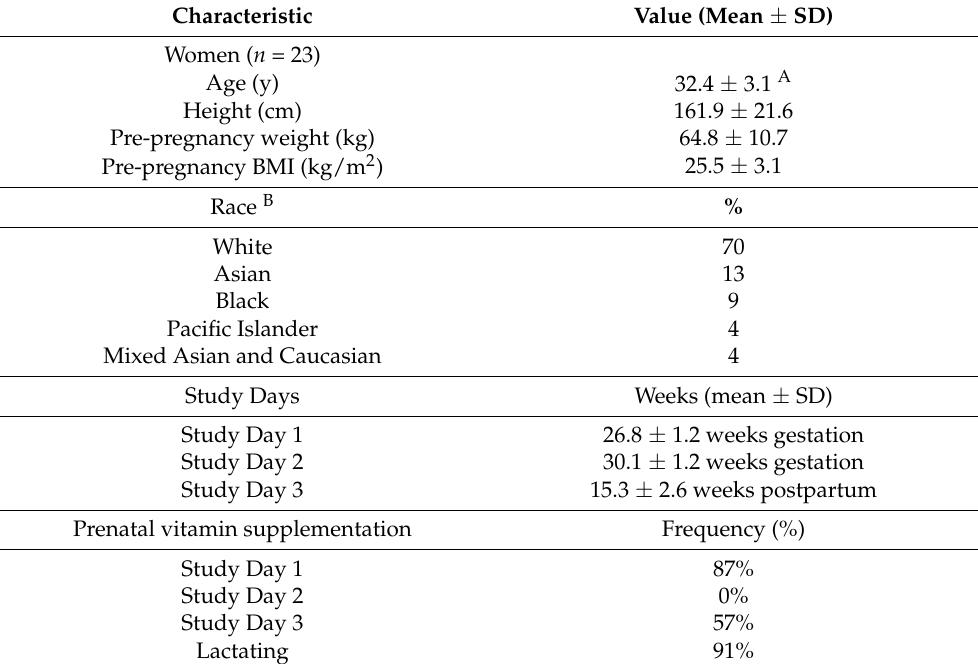
Table 1. Study participant characteristics.